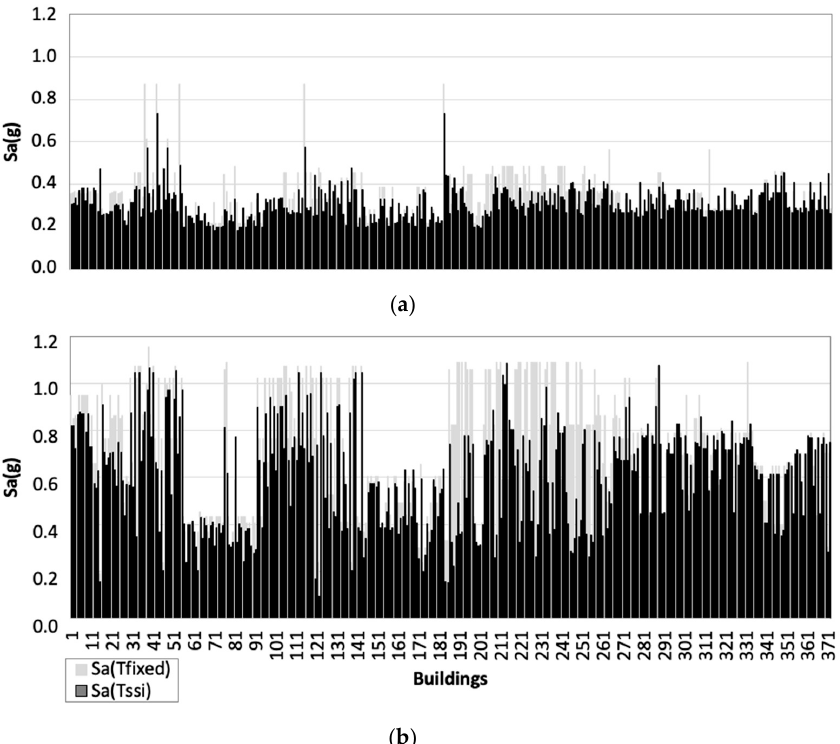
Figure 18. Spectral accelerations S a ( T SSI ) and S a ( T fixed ) evaluated for each building of the south Old Town area (shown in Figure 18c) for ( a ) 1818 input; ( b ) 2018 input.